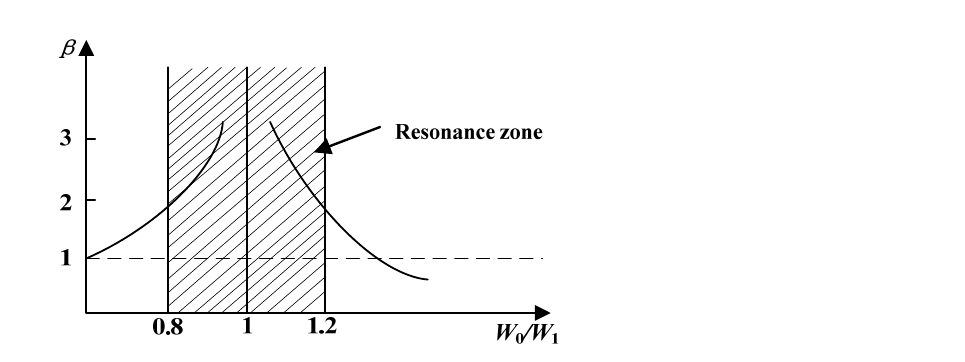
Figure 3. Resonance zone. (Note: β = amplification factor; W 0 = natural frequency; W 1 = excitation frequency).